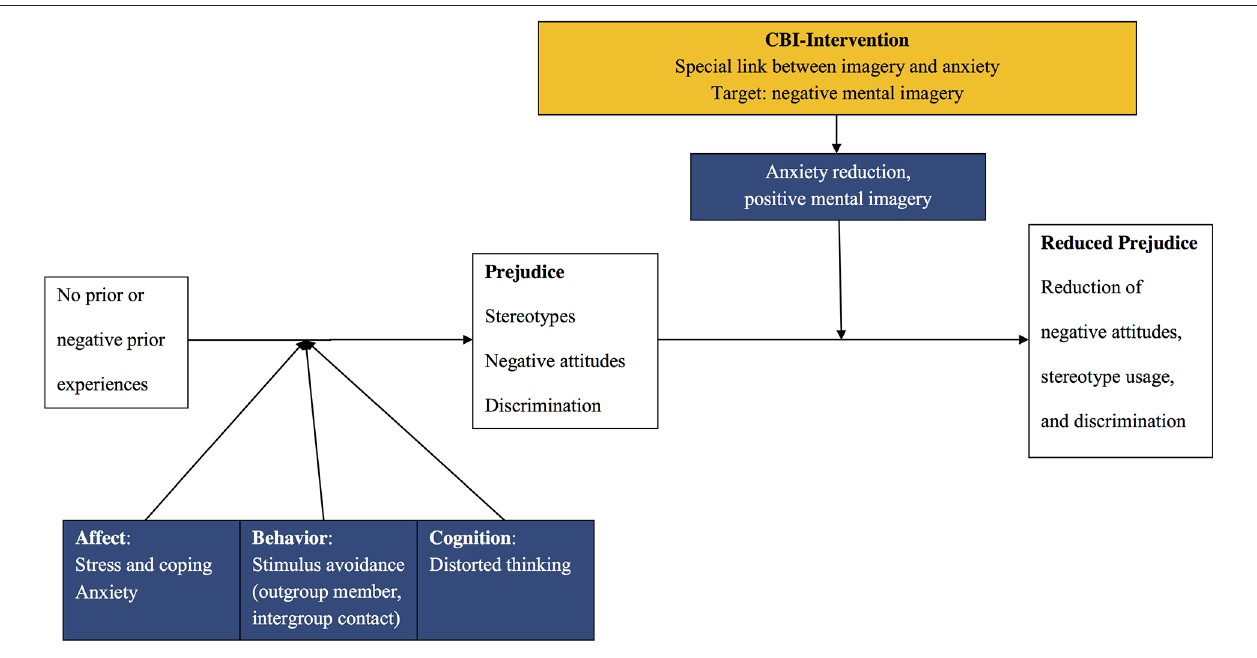
FIGURE 1 | Cognitive-behavioral model of social change